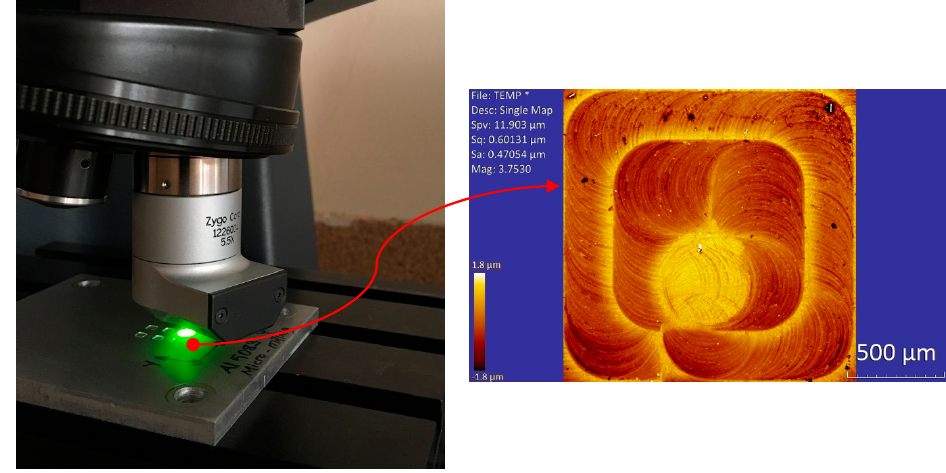
Figure 5. Surface roughness and 3D surface topography measurements.